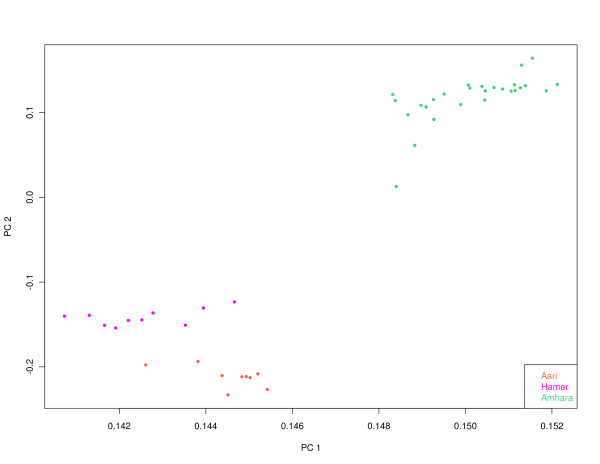
Principal components analysis of Amhara, Aari and Hamer individuals. Principal component (PC)1 (x-axis) versus PC2 (y axis). The Amhara are displayed in green, the Aari in orange, and the Hamer in magenta.